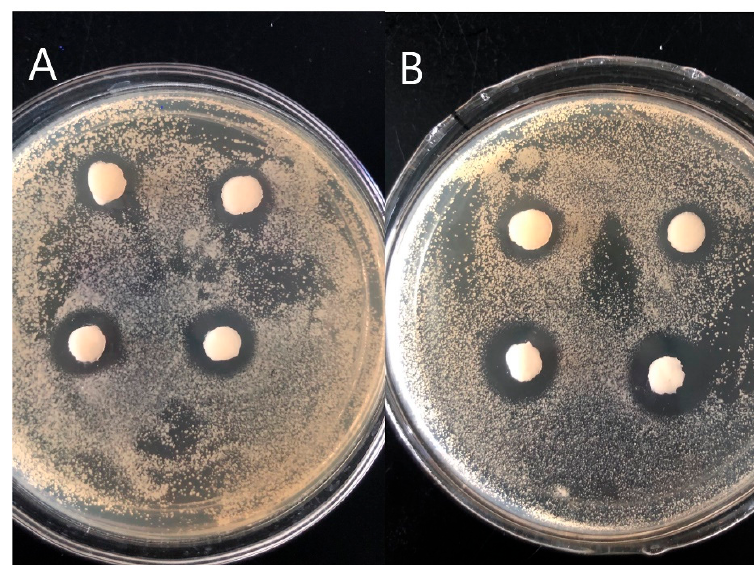
Figure 7. Inhibitory effect against E. coli ( A ), S. aureus ( B ).